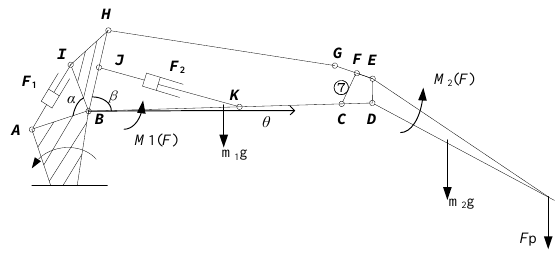
Figure 2. Boom structure and force diagram.